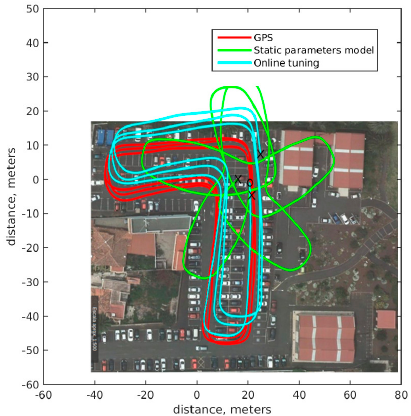
Figure 12. Test after 20 days of tuning odometry. Solid red, GPS based ground truth. green static parameter model. Blue on line tuned neural network model.